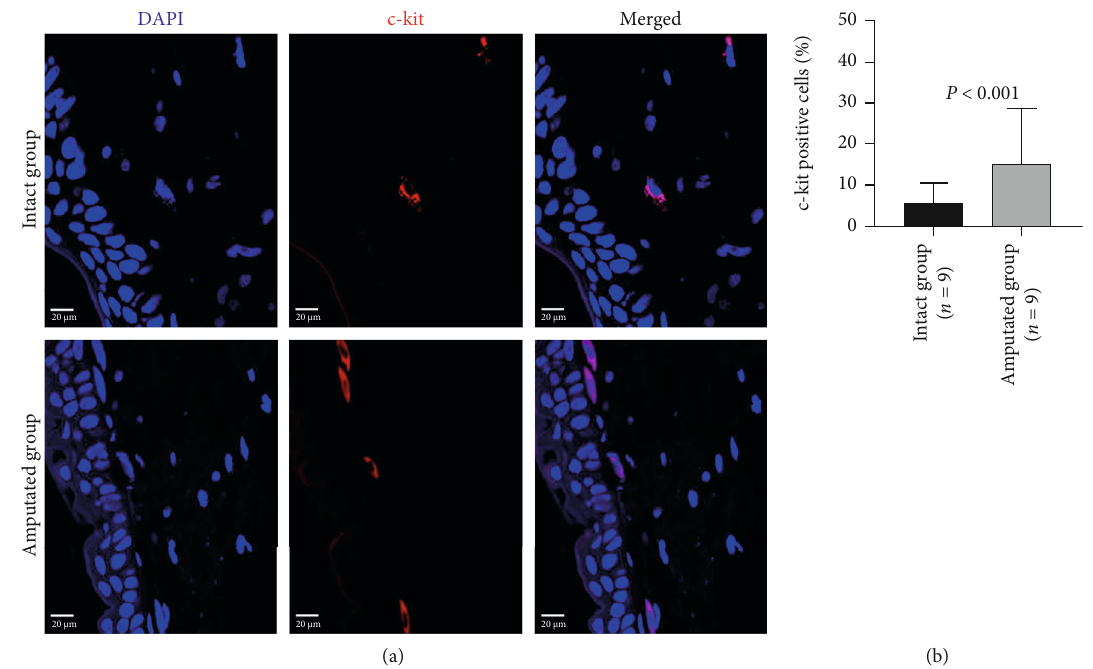
Figure 2: Immunohistochemical analysis on the c-kit-positive stem cells in tails 3 days after amputation. Representative images (a) and quantitative data (b) show the c-kit-positive stem cells in intact tails and amputated tails. Scale bar: 20 μ